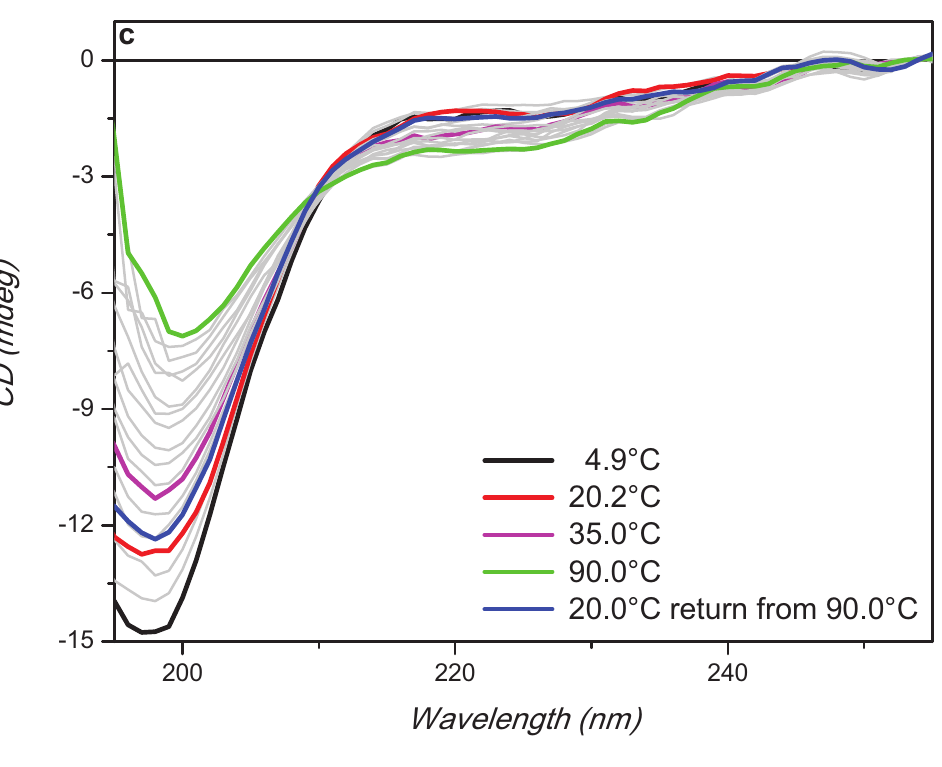
Figure 3. Far-UV SRCD spectra of (cid:2)-synuclein alone ( a ) or in presence of 10 mM ( b ) or 100 mM ( c ) trehalose at different temperature (indicated). (cid:2)-Synuclein concentration was 0.36 mg/mL in PBS buffer, pH 7.4.